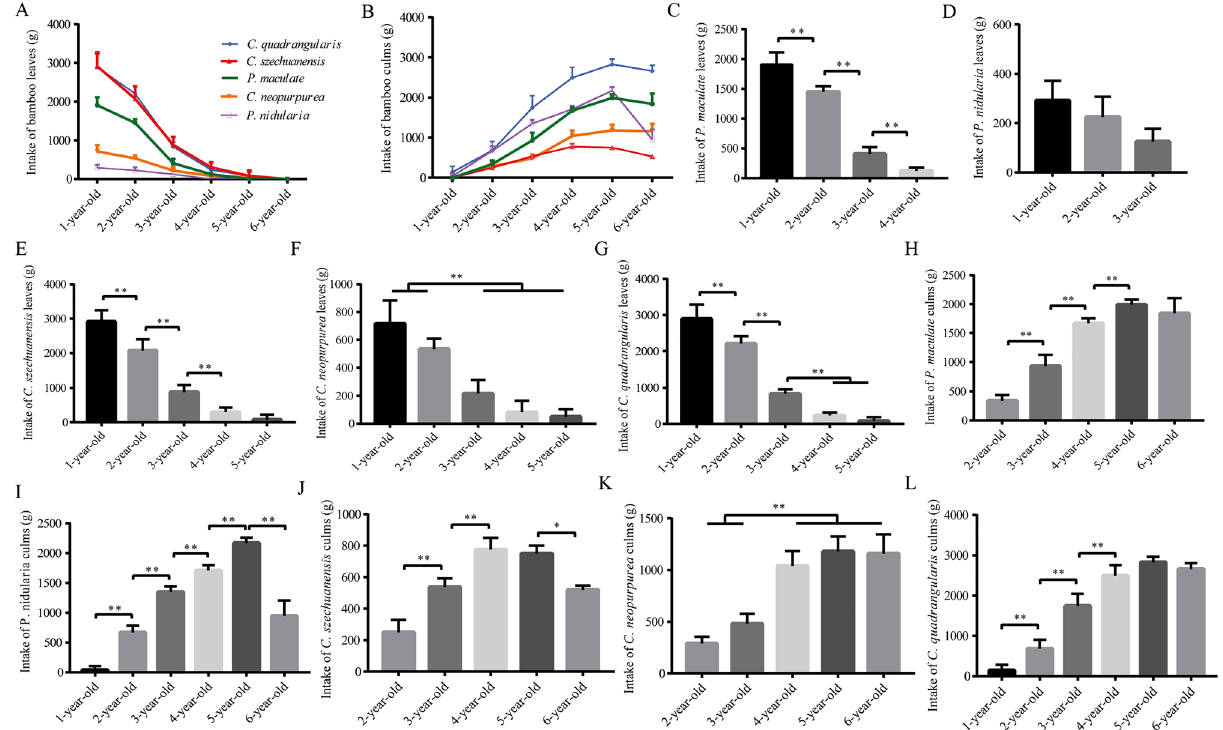
Figure 2. Feed intake of bamboo for captive giant pandas at different bamboo